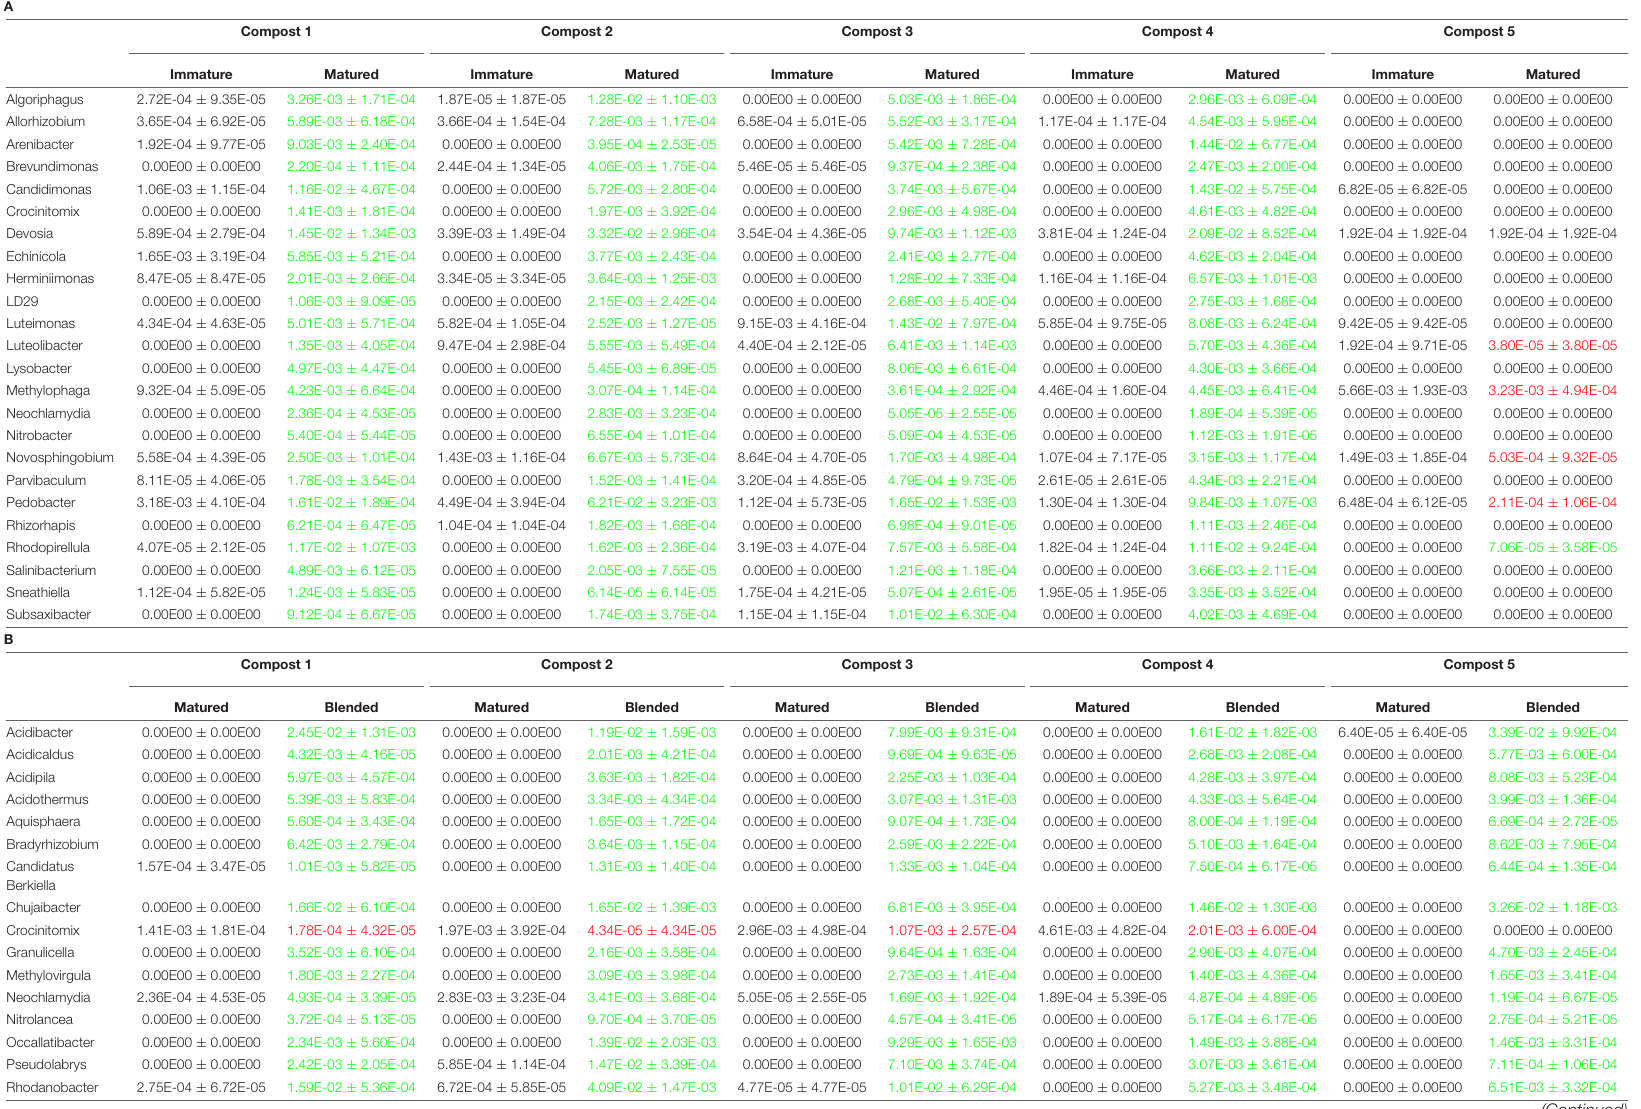
TABLE 1 | Major taxonomical changes in the bacterial